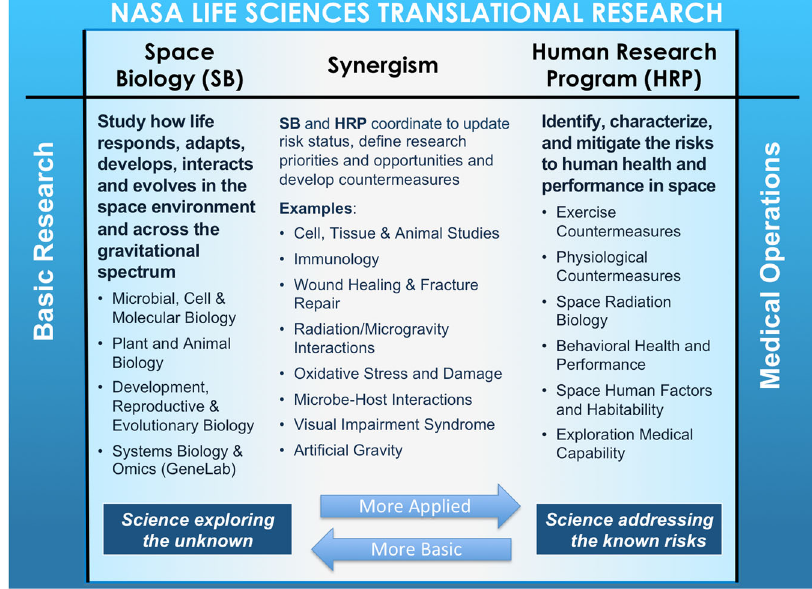
Fig. 2 Space Biology and Human Research Bi-directional Synergism. Basic Space Biology research is done mainly with lower-level model organisms, cells, and tissues. The HRP conducts biomedical science mainly with humans. They synergistically and bi-directionally collaborate in maximizing opportunities for translating a subset of that knowledge to optimize the health and safety of the crew via applications supporting medical